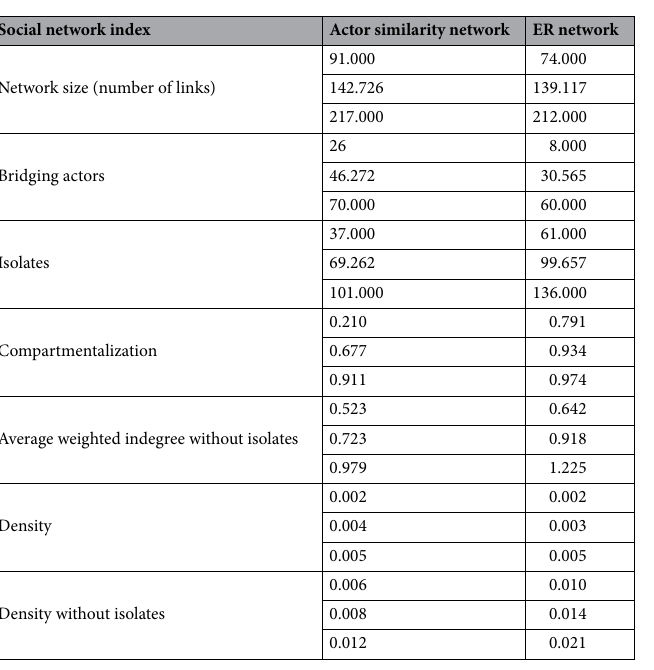
Table 2. Social network indices. Calculated from networks for both network models, a total of 13,122 simulations (6561 each). Density was used in network randomization in Erdős Rényi (ER) network model experiments. For each index, the table shows the minimum value, the mean value and the maximum value for all simulations, in respective order. The full table and descriptions for each index can be found in Supplementary Materials tables S3 and